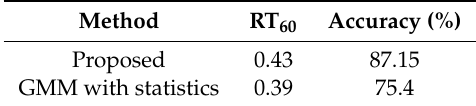
Table 10. Comparison of the proposed method to the previous single-channel distance estimation method. GMM: Gaussian mixture